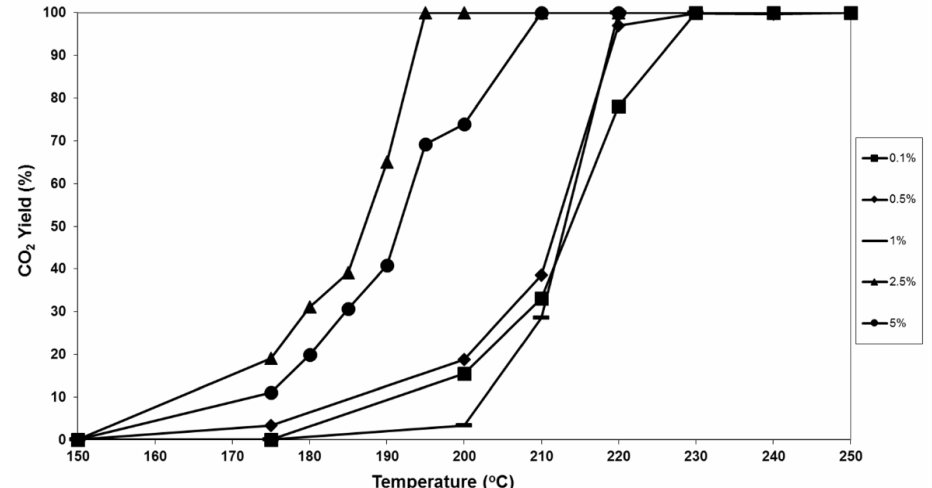
Figure 1. Steady-state conversion of naphthalene to CO 2 as a function of temperature for catalysts with varying platinum loadings on a silica support: ■ 0.1 wt.% Pt; ♦ 0.5 wt.% Pt; ▬ 1.0 wt.% Pt; ▲ 2.5 wt.% Pt; ● 5.0 wt.%